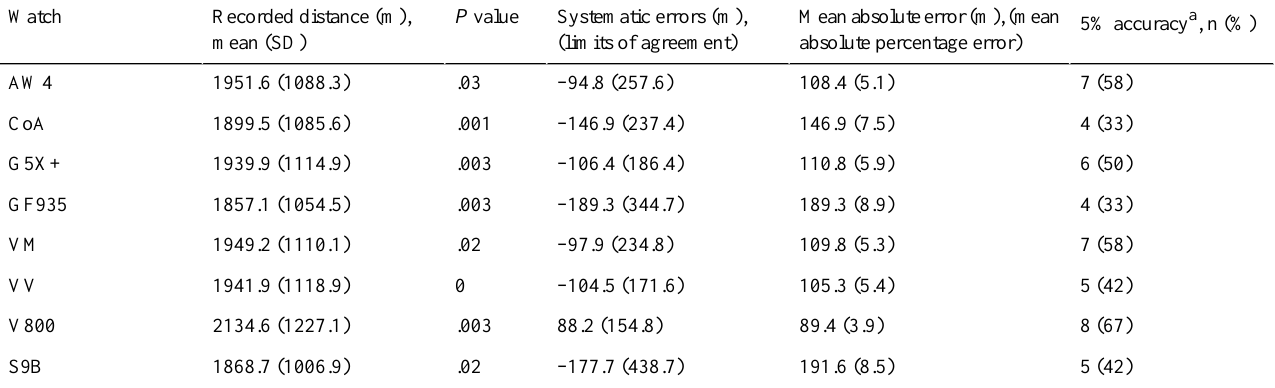
Table 2. Recorded distances and error rates of the eight sport watches obtained in the urban area when compared with the mean reference distance of 2046.4 (SD 1159.7) m